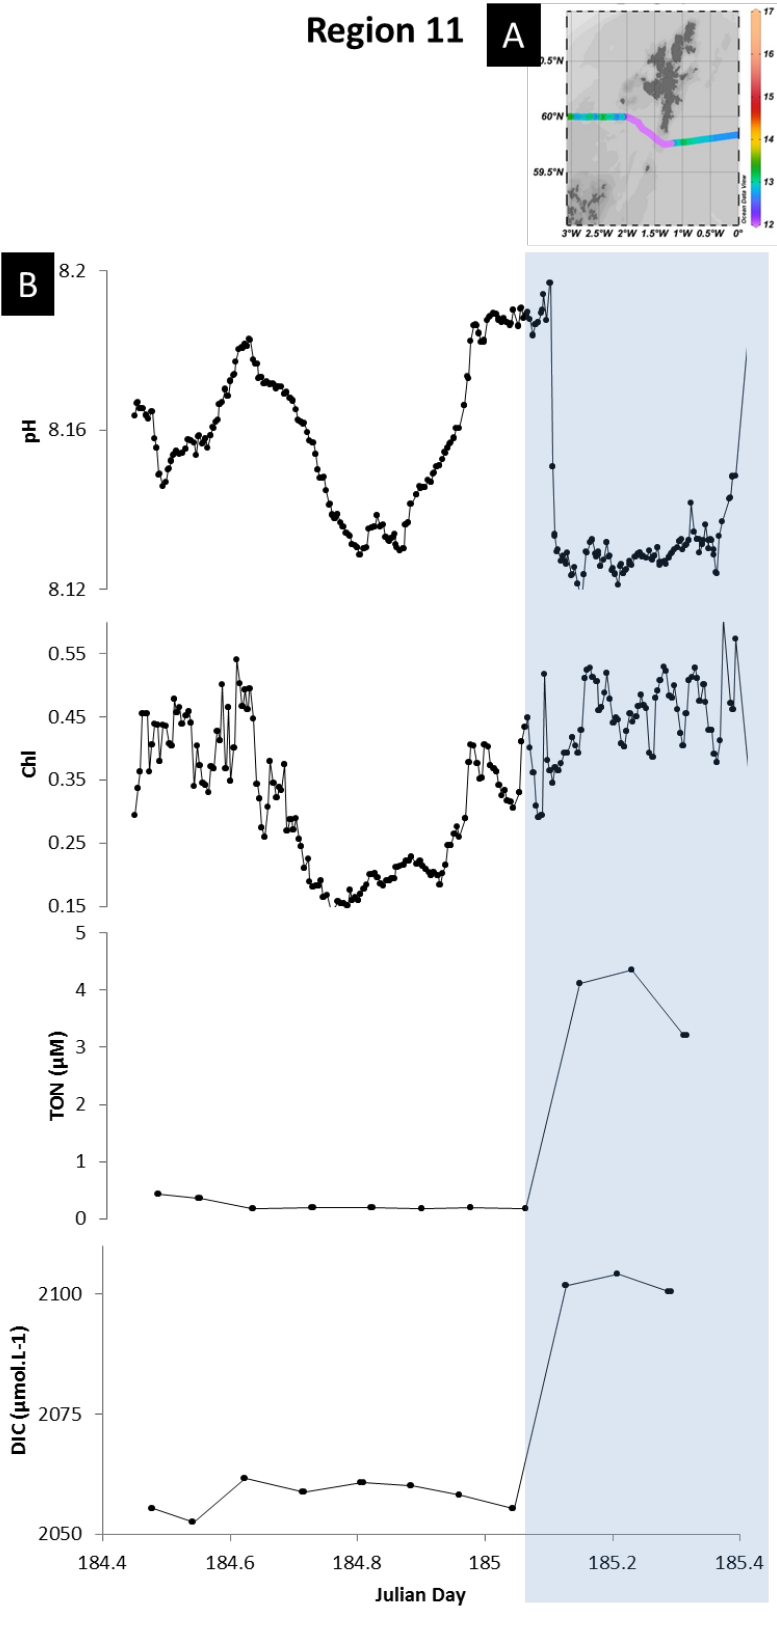
Figure 10. Impact of tidal shelf mixing on sea surface pH. ( A ) Sea surface temperatures observed in region south of the Orkney Islands. ( B ) Time series plots of sea surface pH, chlorophyll, DIC and Nitrate and nitrite concentrations (TON), plotted against Julian day. Map was produced using Ocean Data View (Schlitzer, R., Ocean Data View, odv.awi.de, 2017).